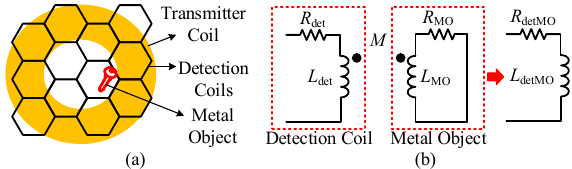
( b ) Figure 4. ( a ) Model of a half of the four ‐ layer rectangular layout detection coils in Maxwell. ( b ) The Structural parameters of the first layer detection coils. 3. Principle of Detection